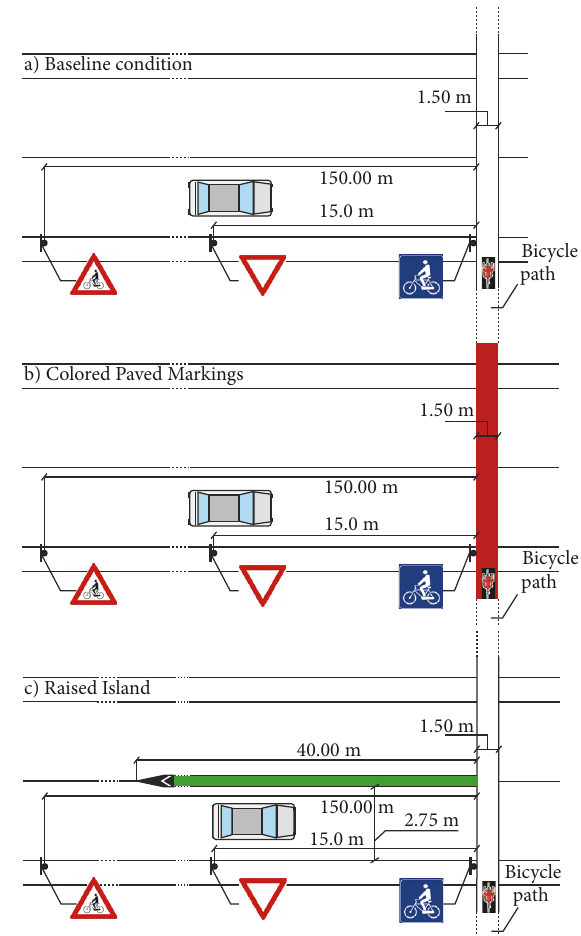
Figure 1: (a) Baseline condition; (b) colored paved markings; (c) raised